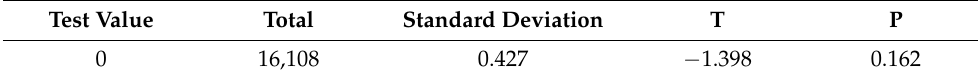
Figure 16. P-P Figure 16. P-P diagram.